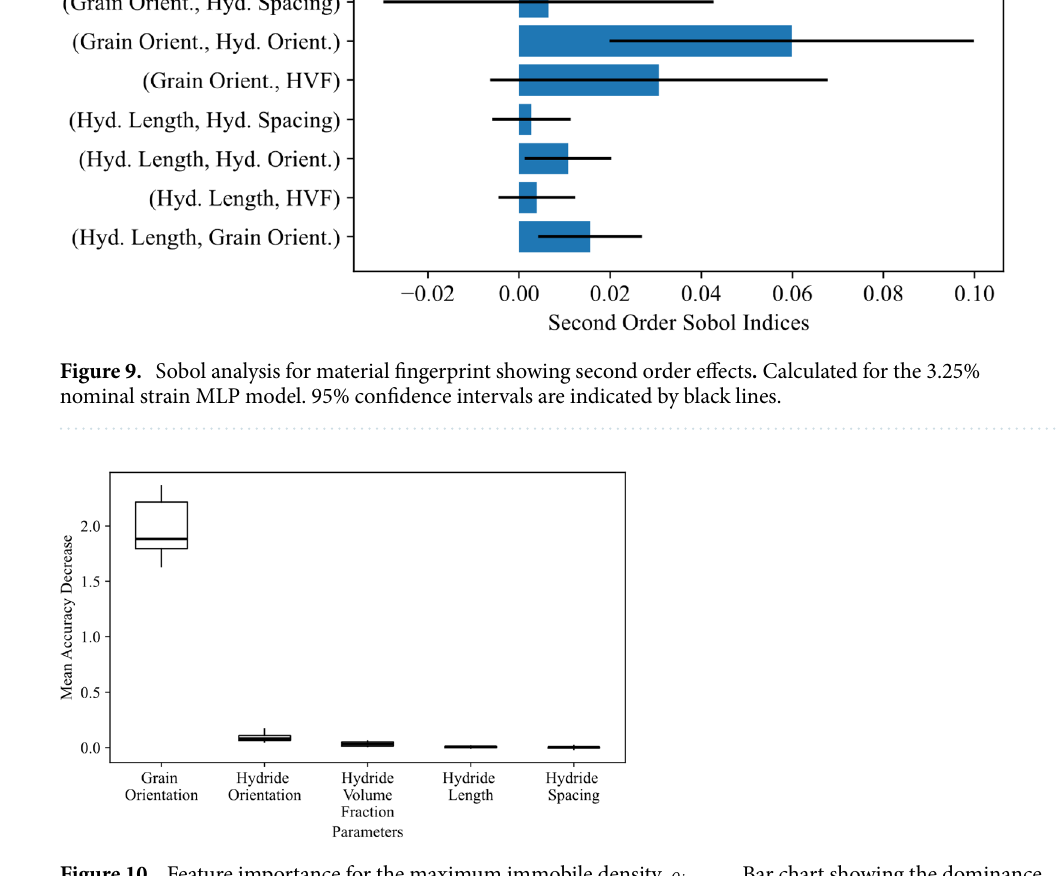
Figure 10. Feature importance for the maximum immobile density, ρ im , max . Bar chart showing the dominance of material texture in predicting extremes of immobile dislocation